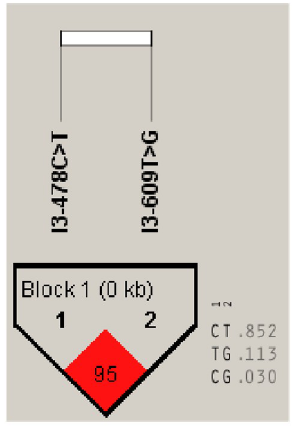
Figure 8. Linkage analysis of SNPs at the DLK1 locus in Chinese Simmental.